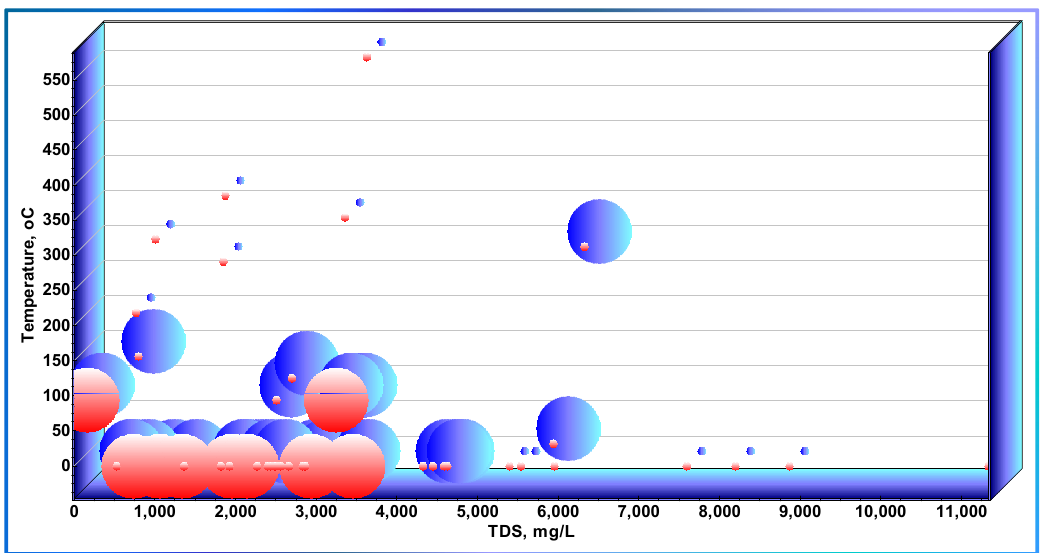
Figure 7. Bubble plot of the TDS and Cu concentration combined interaction on TC ( blue ) and E. coli ( red ).